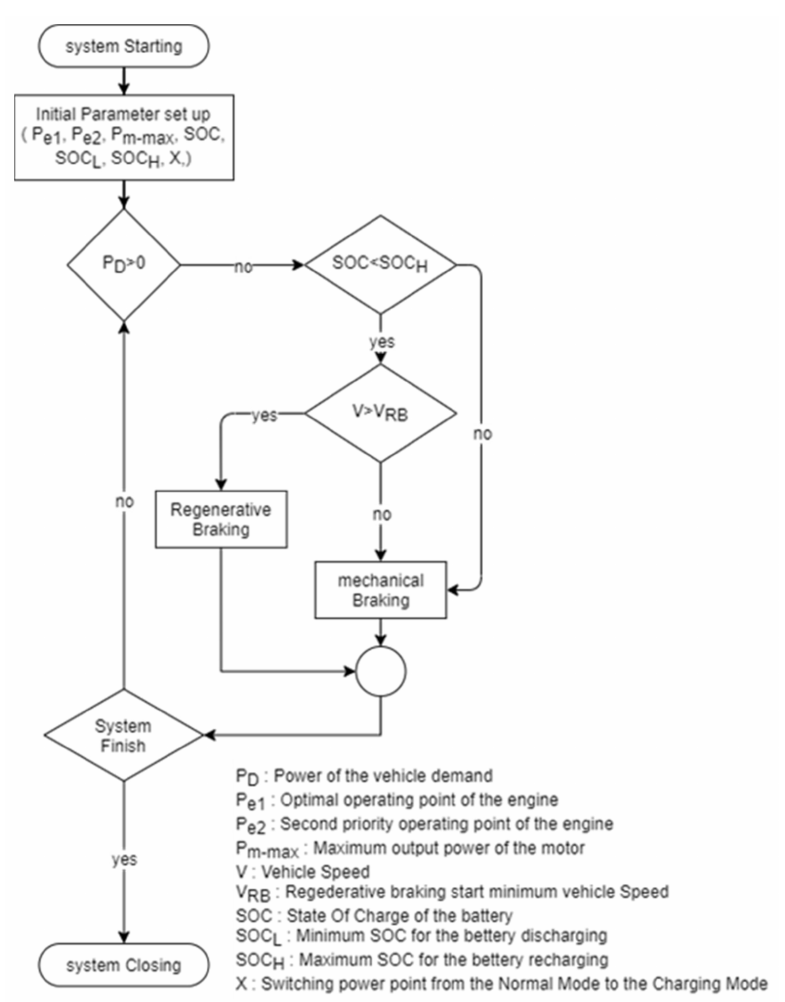
Figure 5. Flowchart of the regenerative braking control